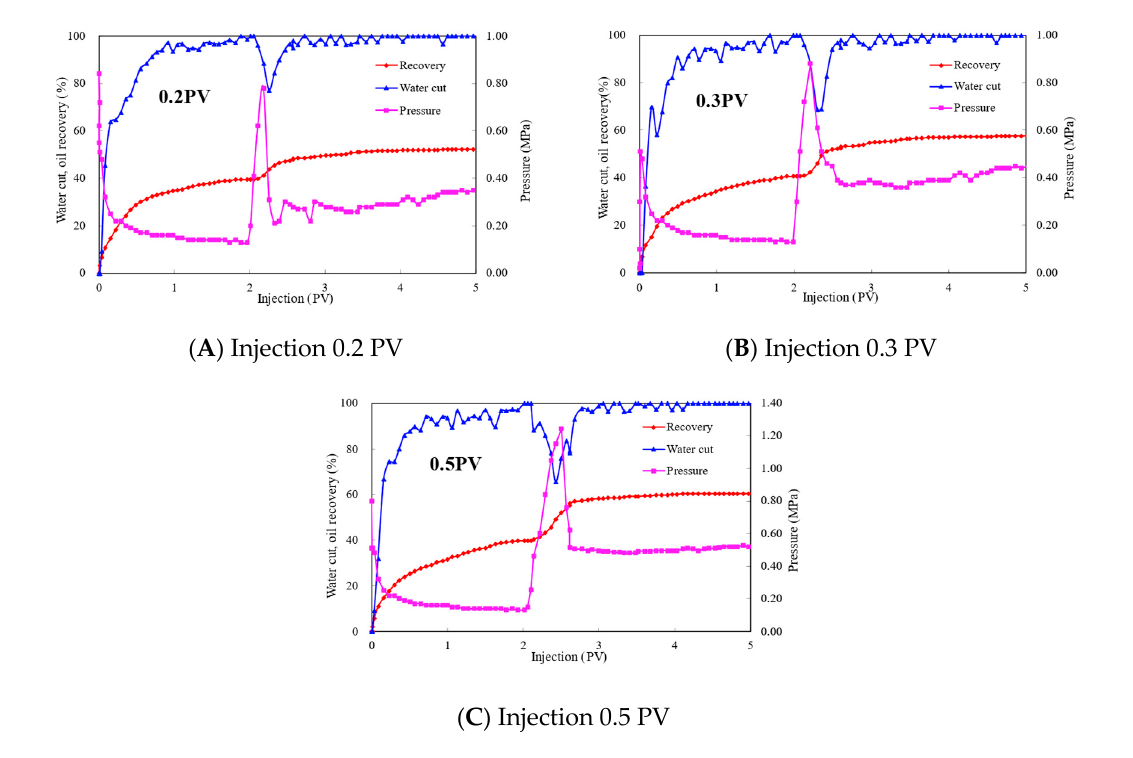
Figure 11. Oil displacement effect curves for different polymer injection PVs.